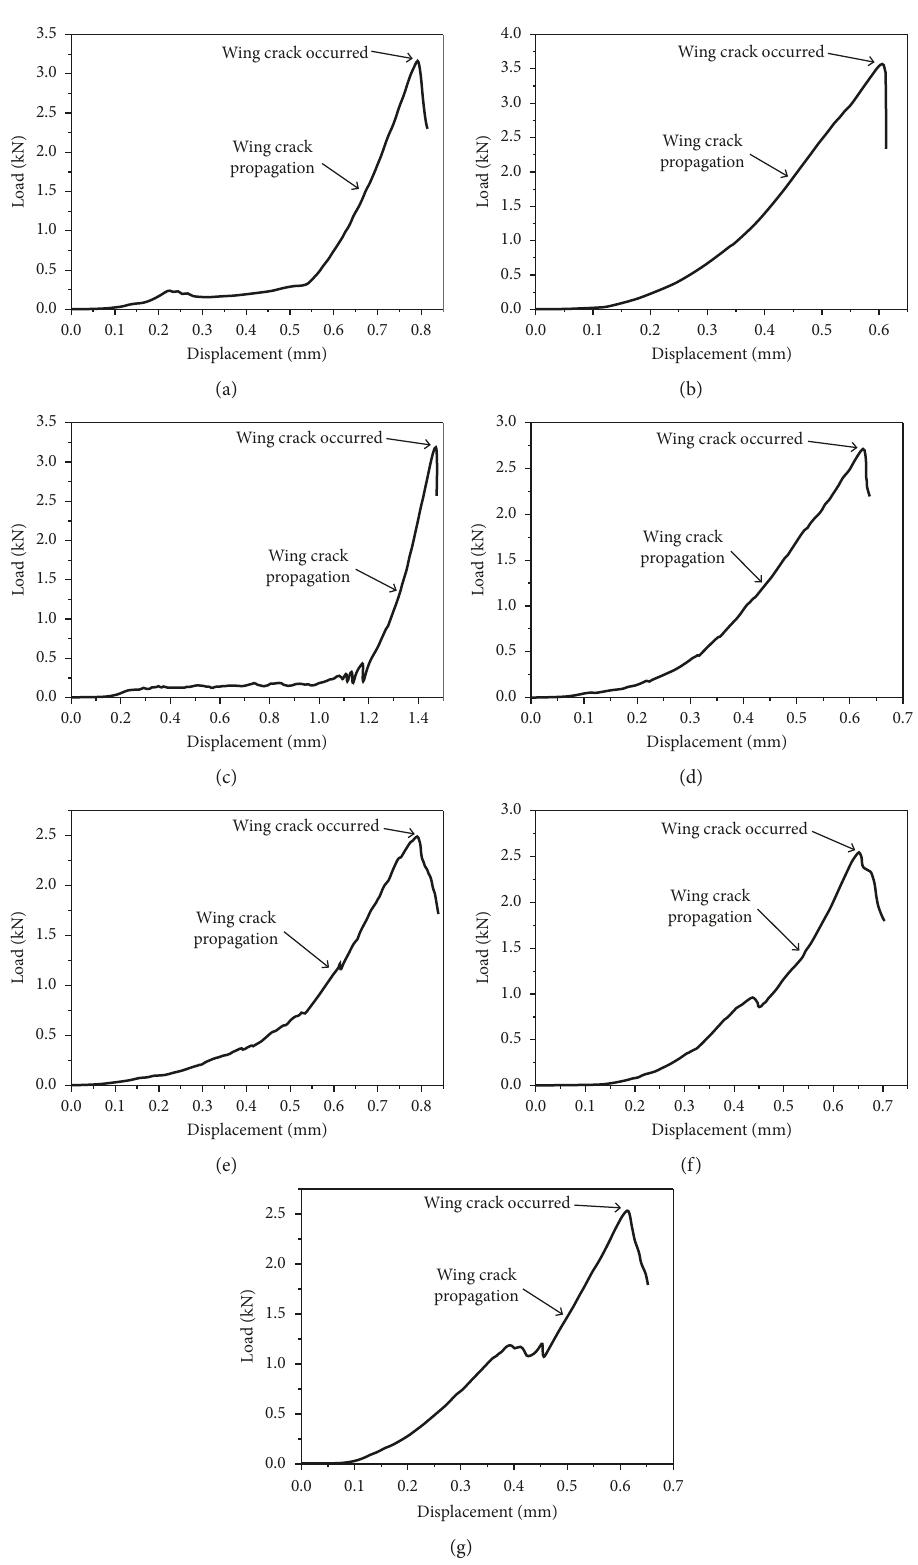
Figure 10: Load-displacement curves of the tested specimens with different pre-existing crack inclination angles: (a) β � 0, (b) β � 15 ° , (c) β � 30 ° , (d) β � 45 ° , (e) β � 60 ° , (f) β � 75 ° , and (g) β � 90 °